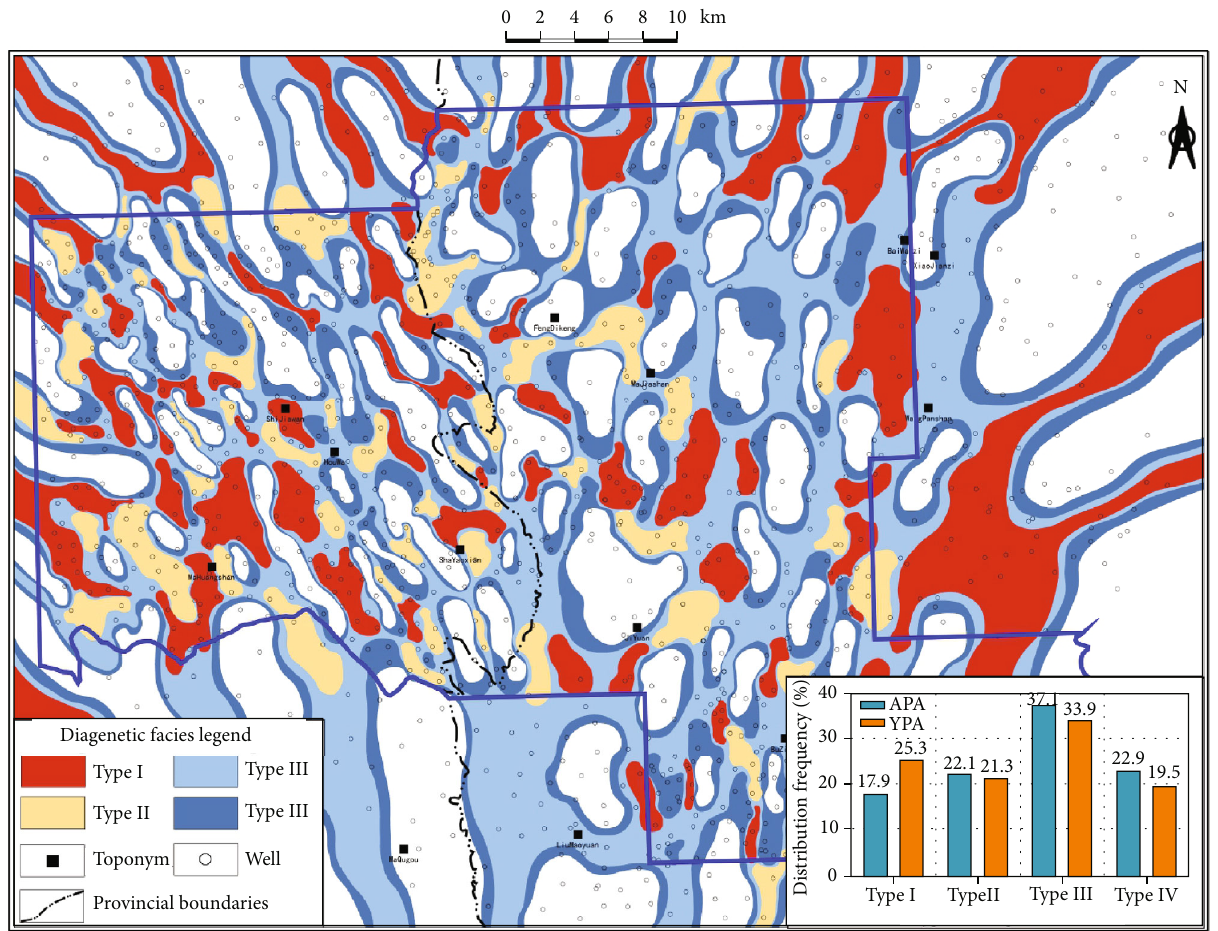
Figure 15: Prediction of the plane distribution of diagenetic facies in the Chang 8